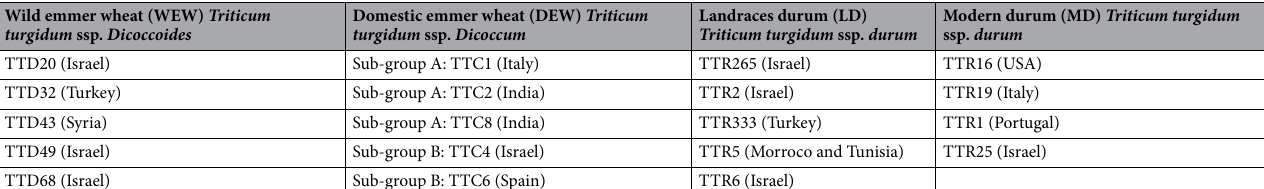
Table 1. Tetraploid wheat lines used in this study. Country of origin for each line is shown in